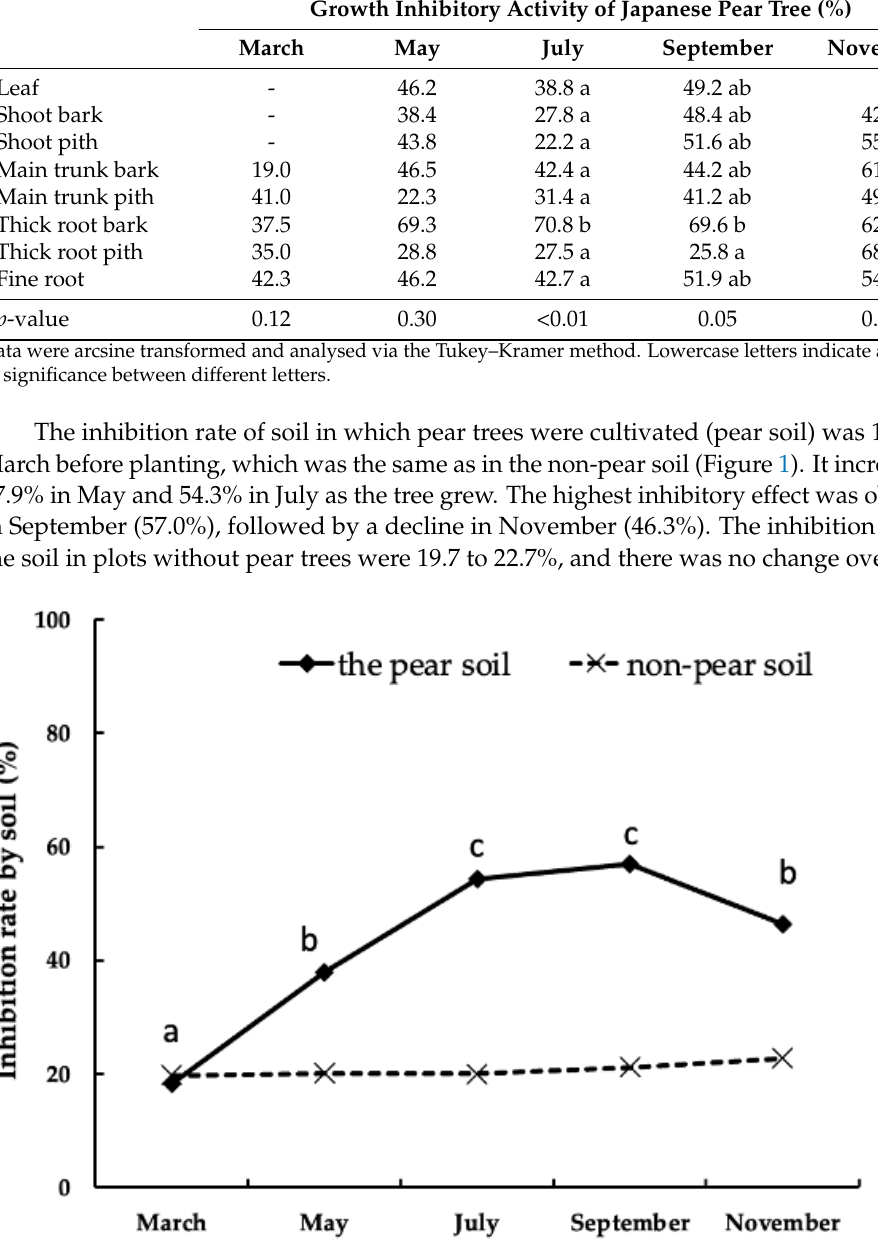
Figure 1. Changes over time in soil inhibition rate after planting Japanese pears. Data were arcsine transformed and analysed by Tukey–Kramer method. Lowercase letters indicate a 5% level of significance between different letters. In Japanese apricots, the growth inhibitory effects of the leaves, shoot barks, thick root barks, and fine roots were 90.8%, 100%, 96.8%, and 100%, respectively (Table 2). The growth inhibitory effects of the shoot pith (65.3%) and thick root pith (55.4%) were both lower than other parts of Japanese apricots. In figs, the growth inhibitory effects of the leaf (96.8%) and thick root bark (84.6%) were higher than shoot pith (57.1%), thick root pith (66.9%), and fine root